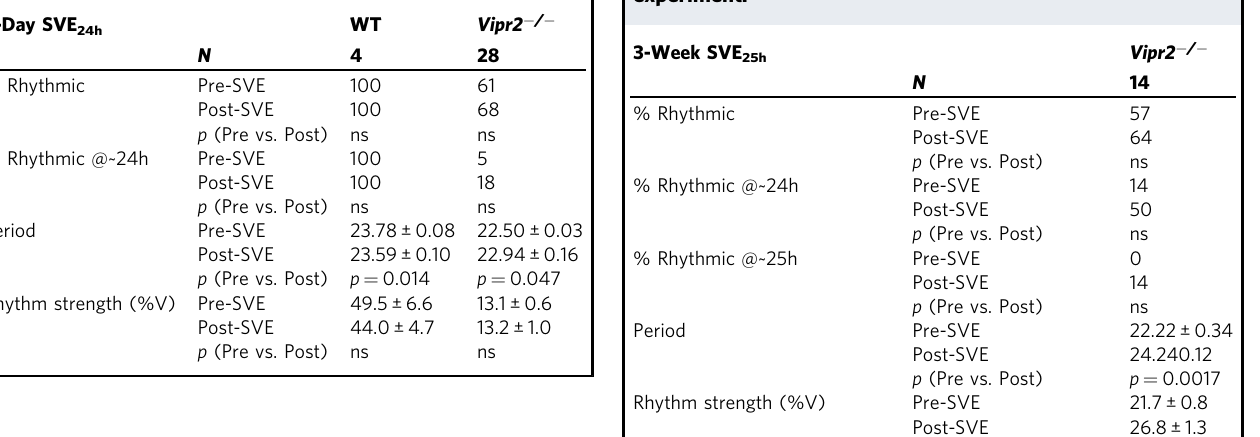
Table 2 Behavioral parameters for 8-day SVE experiment. Table 3 Behavioral parameters for 3-week SVE